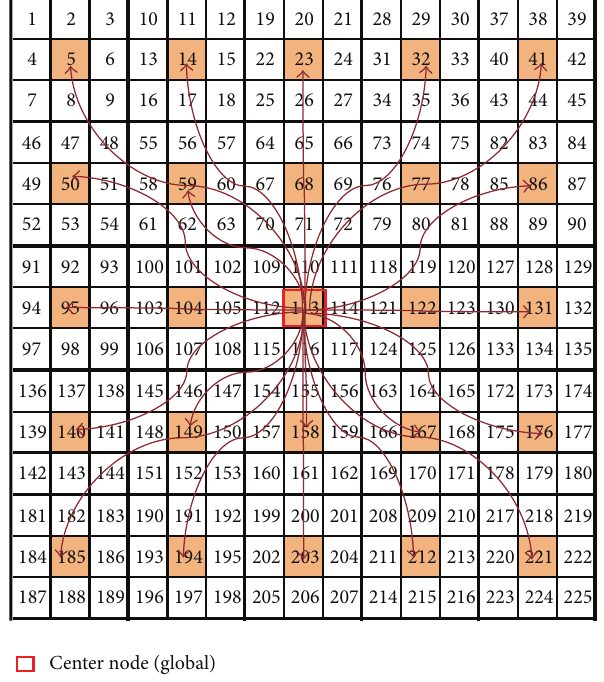
functions consist of five 2D functions and four 30D